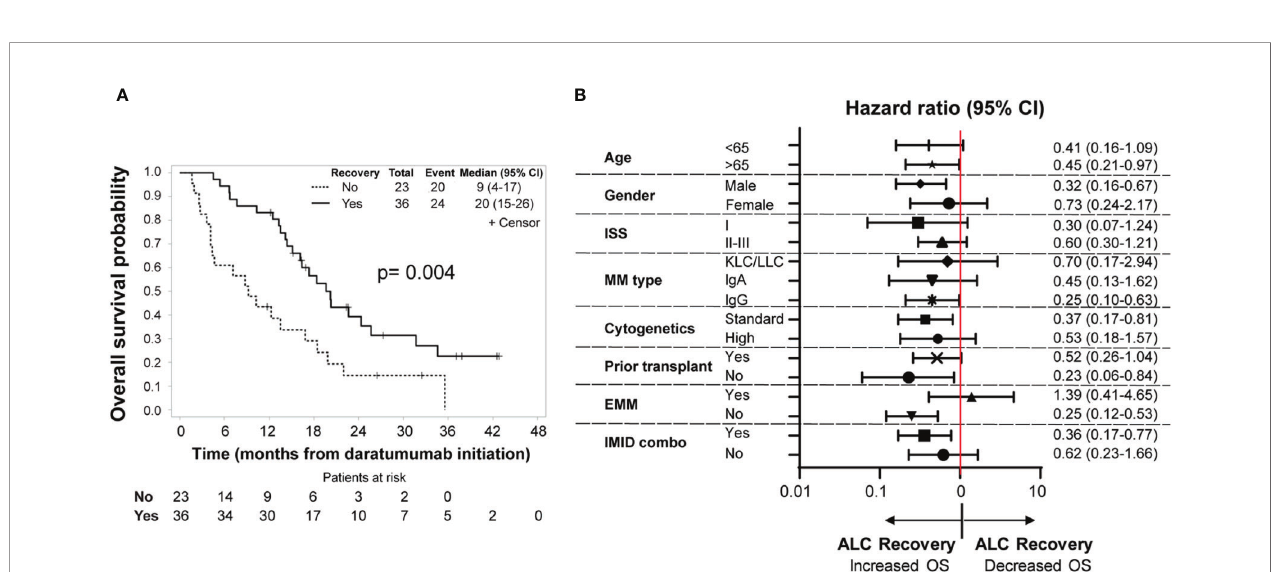
FIGURE 3 | (A) Overall survival. Kaplan – Meier analysis of overall survival among patients who developed severe lymphopenia (n = 59). The P value is based on a log − rank test (p-value = 0.004). The solid line represents the ALC recovery group (ALC above or equal to 500 lymphocytes/ m l), which includes 36 patients, while the dotted line show the no ALC recovery group, which includes 23 patients. Time is counted in months from day of initiation of daratumumab. (B) Subgroup analysis of overall survival in patients with severe lymphopenia. Shown are the hazard ratios of ALC recovery for overall survival in prespeci fi ed subgroups of patients with severe lymphopenia (ALC below 500 lymphocytes/ m l). n = 59 patients. Hazard ratios and 95% CIs are provided. Time is counted in months from day of initiation of daratumumab. ISS, International Staging System. ISS consists of three stages, with higher stages associated with more severe disease: stage I, serum b 2- microglobulin level less than 3.5 mg/L and albumin level more than 3.5 g/dL; stage II, neither stage I nor III; and stage III, serum b 2-microglobulin level more than 5.5 mg/L. Cytogenetics risk pro fi le. A high-risk cytogenetic pro fi le was de fi ned by a fi nding of t(4;14), t(14;16), t(14;20), del(17p), or hypodiploid karyotype. All other patients belong to the standard risk group. EMM, Extramedullary Multiple Myeloma. IMID combo, Immunomodulatory drug- daratumumab combination.